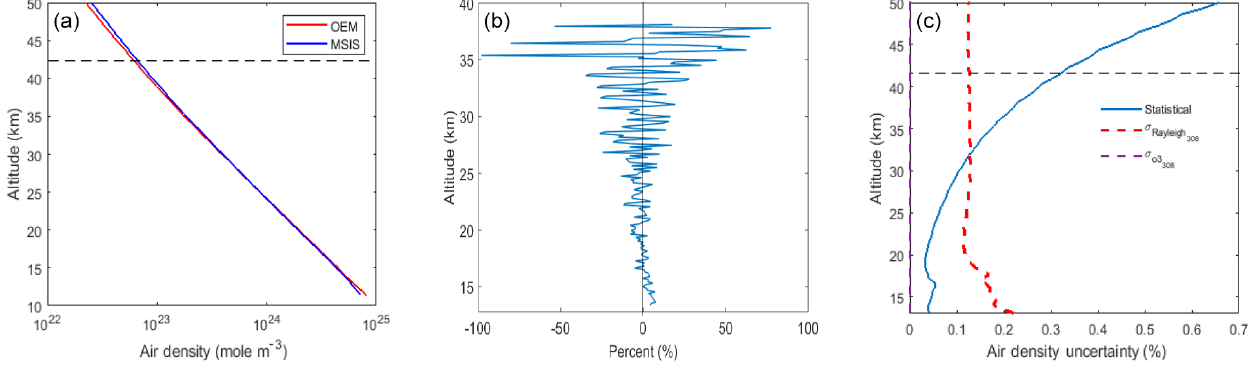
Figure 12. (a) The retrieved air density (blue line) is plotted against the a priori profile (red line). (b) The percentage difference between the scaled relative air density generated from the Raman channel and the OEM air density retrievals. The difference is less than 10%. (c) The statistical uncertainty of the OEM retrieval of air density (blue), the Rayleigh-scatter cross section uncertainty for the 308nm channel (red), and the ozone absorption cross section in both channels